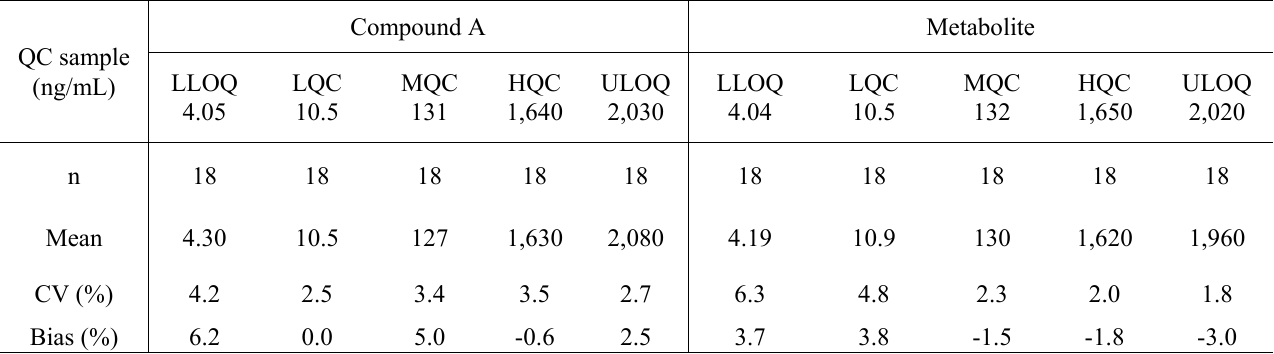
Table 3. Inter-day accuracy and precision of the LLOQ, LQC, MQC, HQC, and ULOQ evaluation samples for the rabbit whole blood method. Mean values in the table are average of the back-calculated concentrations from the standard curve.